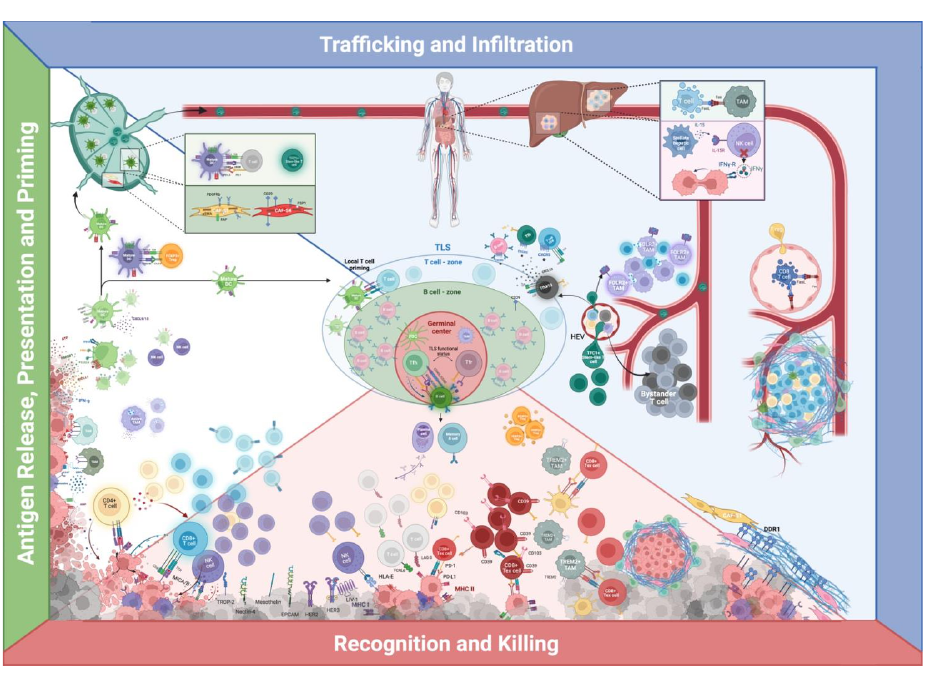
Figure 3. The cancer-immunity cycle and multiplexed in situ spatial protein profiling of relevant cellular interactions and niches in breast cancer. Green — antigen release, presentation and priming: tumor-associated antigens (TAAs) are captured by innate immunity, whose activation is enhanced by damage-associated m olecular patterns (DAMPs) and limited by mechanisms altering TME’s ad- juvanticity, as depicted in Figure 2. Activated dendritic cells (DCs) can therefore migrate to tumor- draining lymph nodes (TDLN), where they can prime naïve T cells. Regulatory FOXP3+ T cells (Treg) can target migrating DCs and thus limit T cell priming. NK cells can favor DCs ’ recruitment and physically interact with DCs and, in TDLN, DCs ’ interaction with T cells can foster a transiently activated T cell phenotype or stimulate a stem-like T cell phenotype. Different subtypes of cancer- associated fibroblasts (CAFs) can populate TDLN and influence the incidence and pattern of metas- tasis, as CAF-S1 and S4. DCs can prime T cells in tertiary lymphoid structures (TLS), thus bypassing TDLN . Blue — trafficking and infiltration: cellular components of the immune system must access and repopulate the TME to exert cancer-immune control. On the far right: cancer cells can limit CD8+ T cells’ endothelial access by inducing the expression of FASL on tumor -associated endothe- lial cells (TA-EC), meanwhile positively regulating regulatory FOXP3+ T cell (Treg) passage. Cancer cells can alter T cells intrastromal motility by directly altering the extracellular matrix (ECM) — such as with DDR1 expression — or indirectly modulate ECM-structure by subjugating different CAFs subpopulations. On the right: CD8+ T cells engage in peri-vascular niches with FOLR2+ tumor-as- sociated macrophages (TAMs); TCF+ stem-cell like T cells can access the TME through specialized high endothelial venules (HEVs). Further, in grey, the bystander T cells, whose role in BC is still unclear. In the middle — human figure: TME profiling of metastatic sites. > On the upper portion: Cells can indirectly limit T cell infiltration by systemically depleting T cells through TAMs-mediated siphoning of tumor-specific CD8+ T cells in hepatic metastasis. > On the lower portion: hepatic stel- late cells ’ interaction with NK cells can limit their cancer control ability. TLS present the unique potential of locally stimulating both T cell priming and activation, B cell maturation, and natural antibody production. CXCL13+ follicular T cell helpers (TfhX13) can coordinate CXCR5 positive immune cells into aggregating in multi-cellular structures, which could be the precursors of TLS.